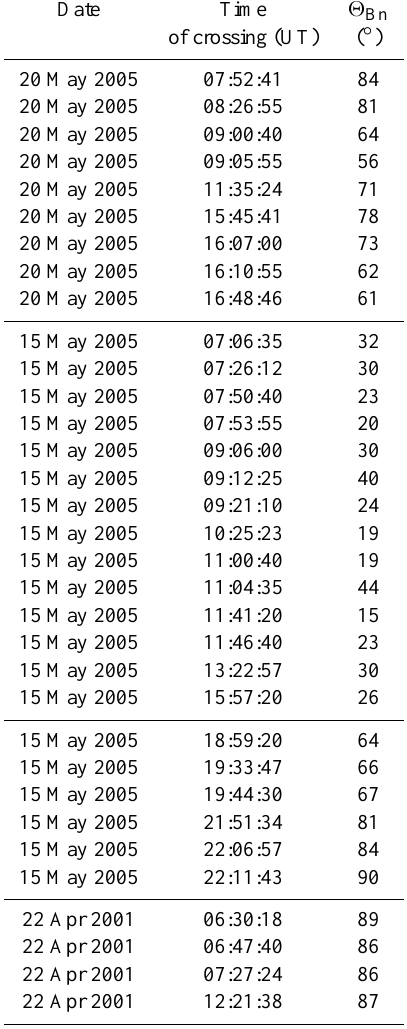
Table 1. 2 Bn at the bow shock crossings estimated with MVA for the first three events. Note that Event 2 is divided into two parts, cor- responding to the quasi-parallel and the quasi-perpendicular config- uration at the bow